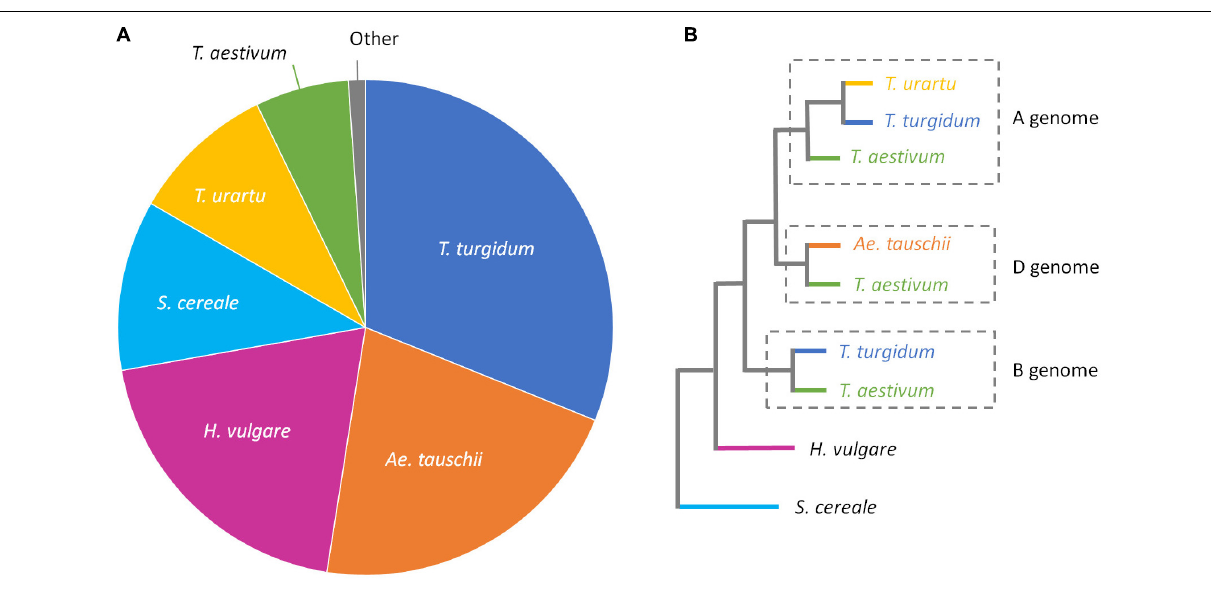
FIGURE 6 | (A) Pie chart showing the best BLAST hits against a combined Poaceae / S. cereale database for captured reads that didn’t map to the IWGSC ‘Chinese Spring’ assembly v1. (B) Phylogenetic tree (redrawn from Zhou et al., 2017), showing the relationship of the species used in our Poaceae / S. cereale